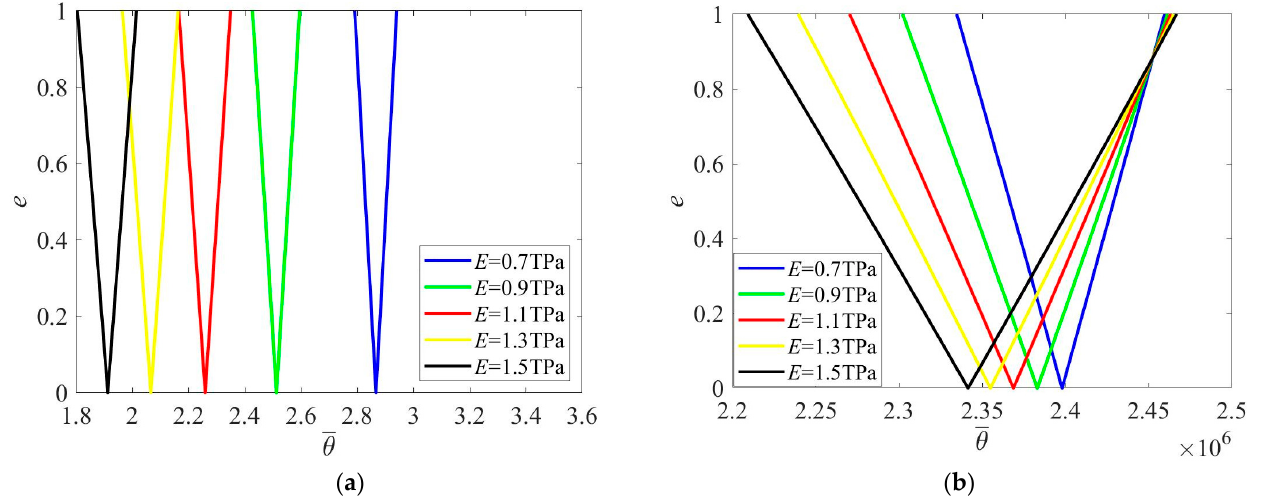
creases when Young’s modulus is raised.